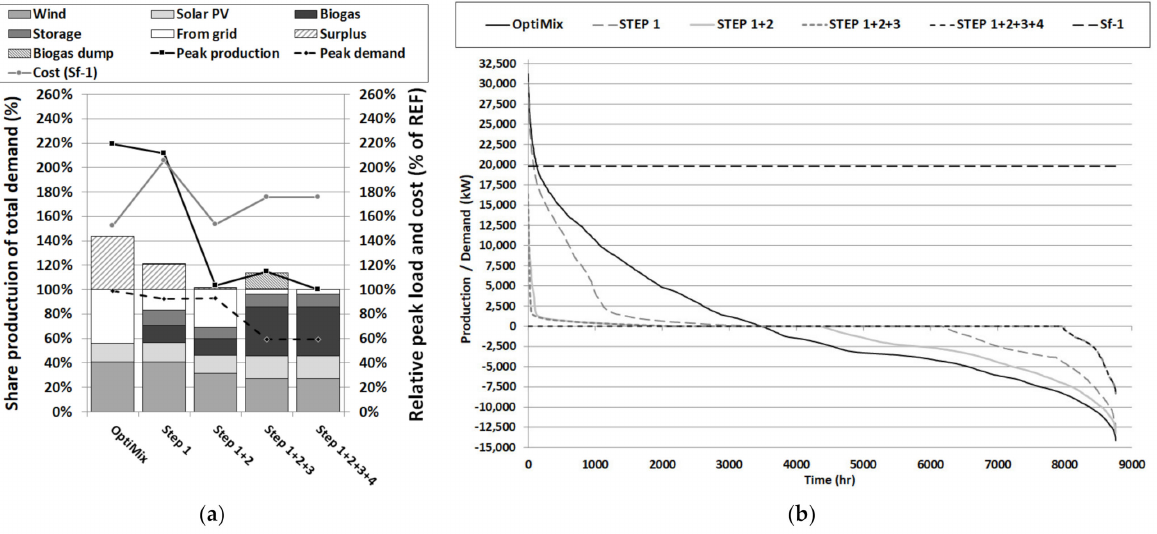
Figure 8. ( a ) Share of total demand per production for optimization scenarios, ( b ) Net load duration curves of the optimiza- tion